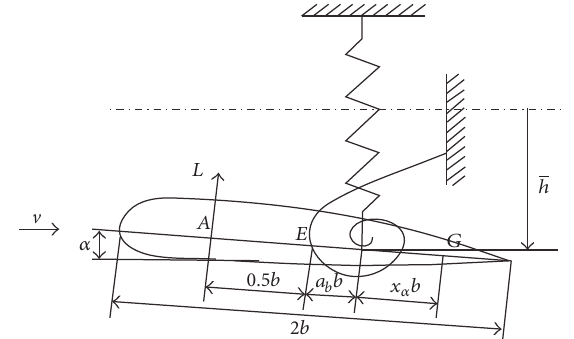
Figure 1: Sketch of a two-dimensional airfoil. 𝑏 is the length of mid- chord, 𝑎𝑏 is the distance between the elastic axis and the mid-chord, and 𝑥𝑏 is the distance between the mass center and the elastic